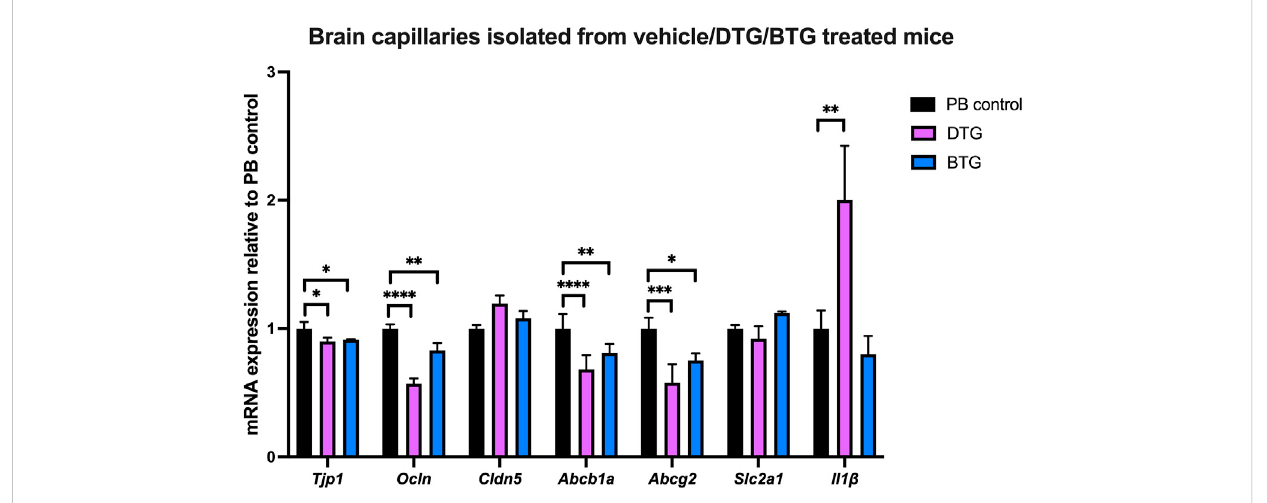
FIGURE 8 mRNAexpressionofTJproteins,membraneassociatedtransportersandproin fl ammatorycytokineinmousebraincapillaries.ThemRNAexpression of Tjp1, Ocln, Cldn5 , Abcb1a, Abcg2, Slc2a1 or Il1 β genes was assessed by qPCR in brain capillaries isolated from mice treated with DTG (5 mg/kg/day), BTG (5 mg/kg/day) or vehicle (regular PB pellet) for 14 days. Results are presented as mean relative mRNA expression ±SEM normalized to